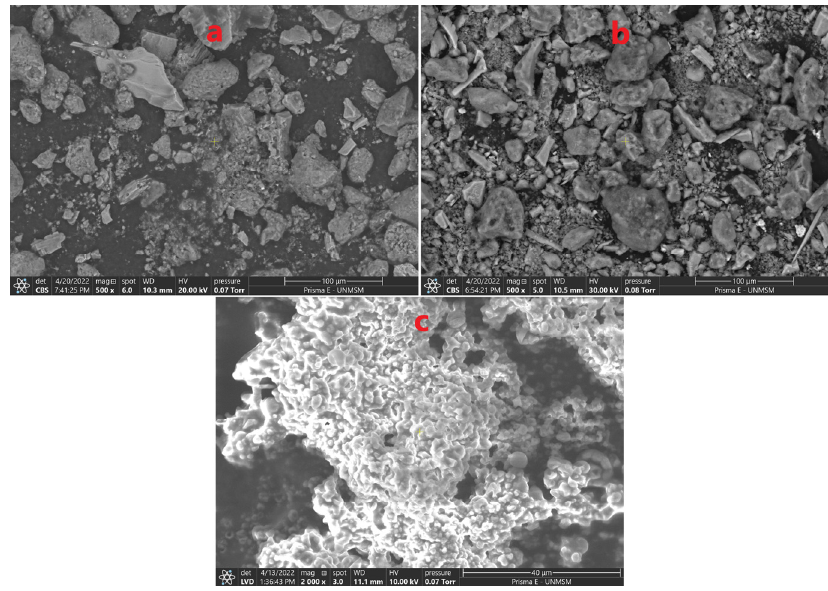
Figure 2. SEM images; ( a ) natural clay HMB, ( b ) activated clay HMB-Act, ( c ) CH hydrocolloid.